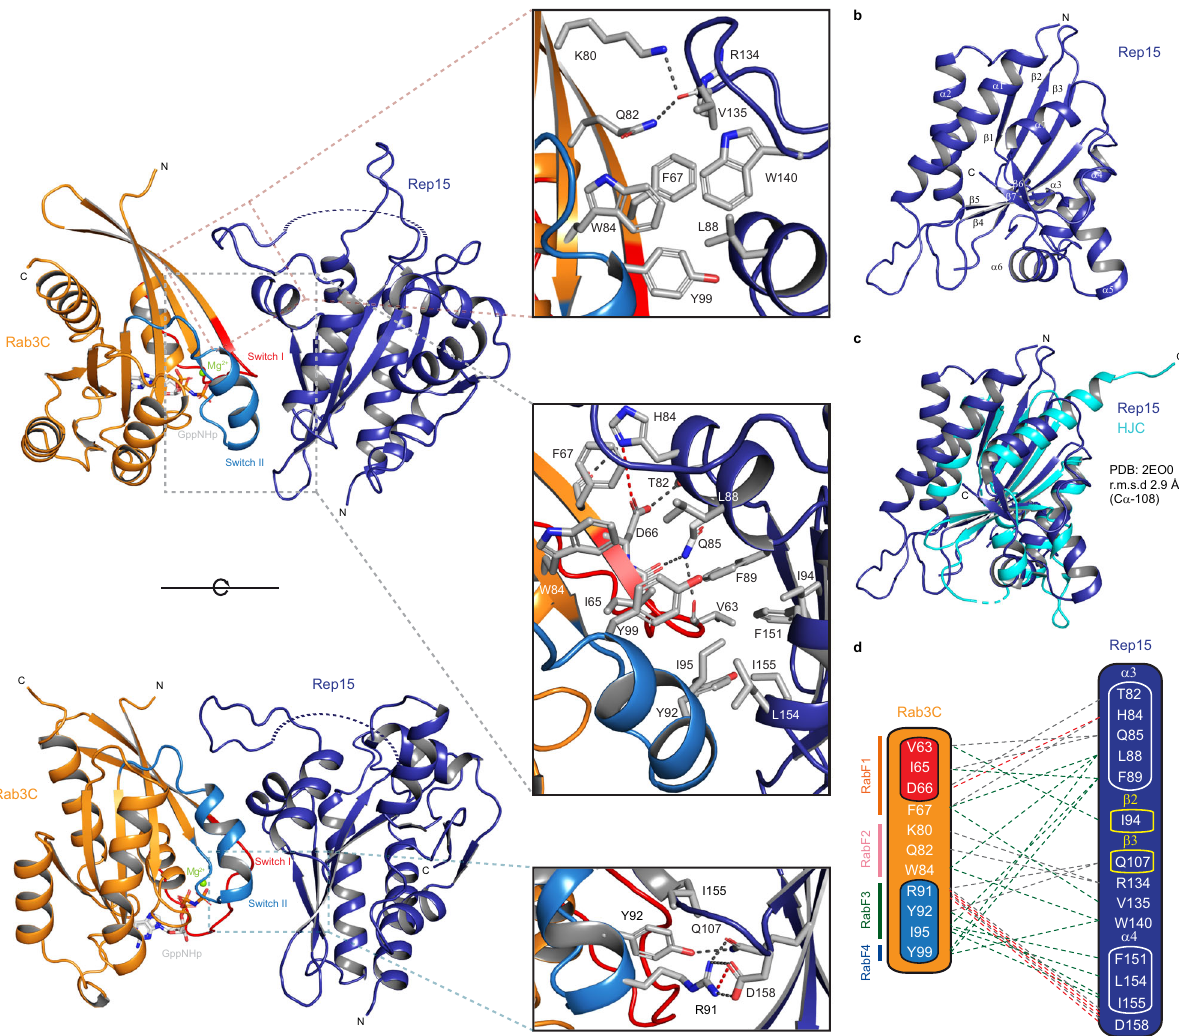
Fig. 4 Crystal structure of the Rep15:Rab3C GppNHp_Q222H_10-227 complex. a Cartoon representation of the Rep15:Rab3C GppNHp_Q222H_10-227 complex. Rab3C (orange) binds to Rep15 (blue) via its switch I, switch II and interswitch regions. Switch I and switch II regions are highlighted in red and sky blue, respectively. Mg 2 + ion is shown as a green sphere and GppNHp is shown in stick representation. Insets show the zoom-in on the binding interface of Rep15 and Rab3C GppNHp_Q222H_10-227 . Key interactions at the Rep15:Rab3C GppNHp_Q222H_10-227 interface are shown in stick representation and labeled. b The Rep15 is composed of 7 α -helices and 7 β -sheets forming a novel α + β fold. c Structural superposition of Rep15 (blue) and Sulfurisphaera tokodaii HJC (cyan, PDB: 2EO0). d Schematic illustration of the Rep15:Rab3C binding interface. Hydrogen bonds and ionic interactions are shown in gray and red dashed lines, respectively. Green dashed lines indicate the hydrophobic interactions. RabF1, RabF2, RabF3, and RabF4 motifs are shown in gray, red, green, and purple,